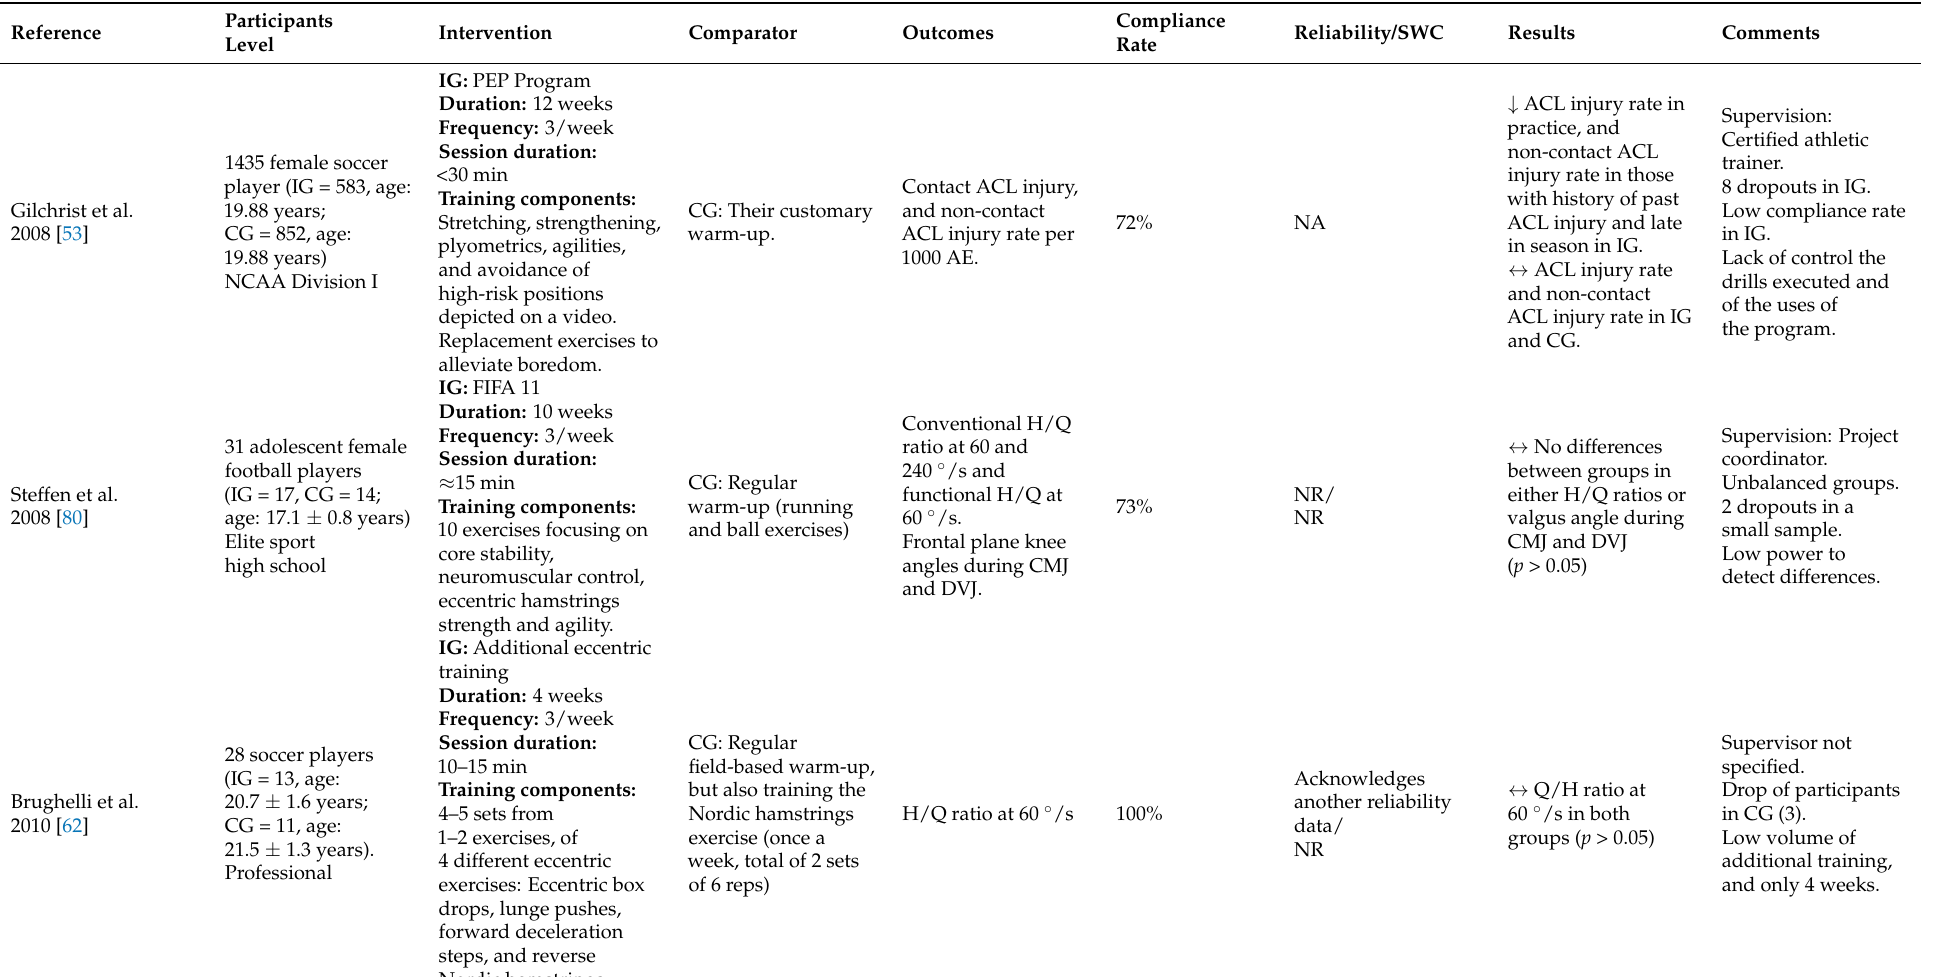
Table 2. Characteristics of the randomised-controlled trials included in the systematic